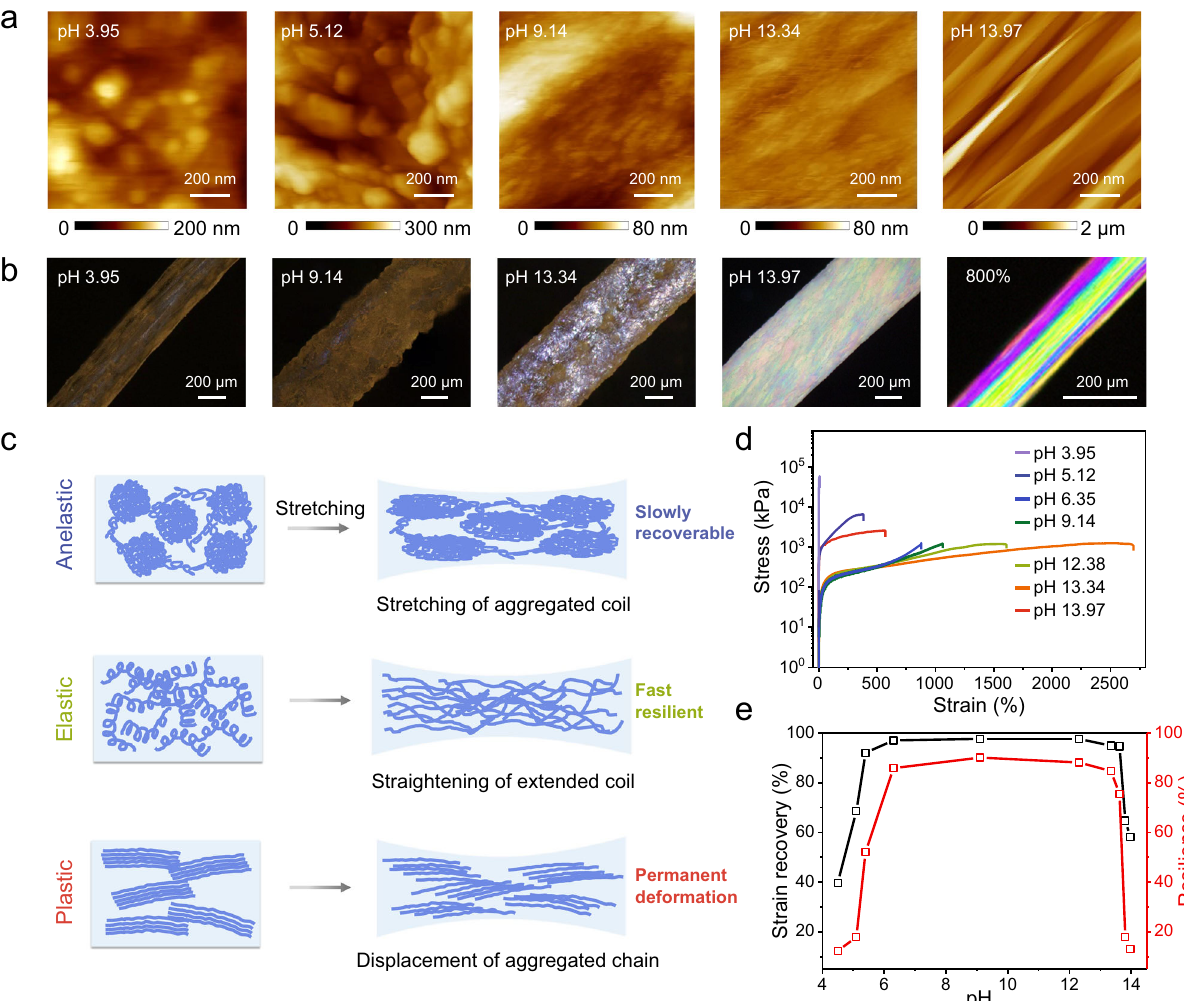
Fig. 2 Structural and mechanical characterization for the single-composition polyelectrolyte hydrogel micro fi bers of evolving macromolecule conformations. a AFM images of hydrogel micro fi bers of different pH. b POM images of micro fi bers of different pH, and pH 9.14 micro fi ber at 800% strain. c Schematic illustration of the response of different macromolecule network architectures to the mechanical loading. d Strain-stress curves of the hydrogel micro fi bers. e Mechanical resilience and strain recovery of the micro fi bers under a 200% strain